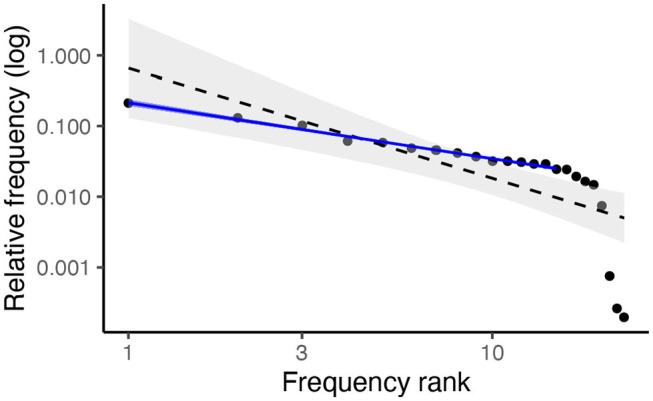
Log-log plot of frequencies vs. frequency ranks in Walmajarri. When a linear model is fitted to the full distribution (dashed black), high and low frequency segments are overestimated and mid-rank segments are underestimated. When lowest-frequency segments are removed from the model (solid blue), the model appears to fit well.